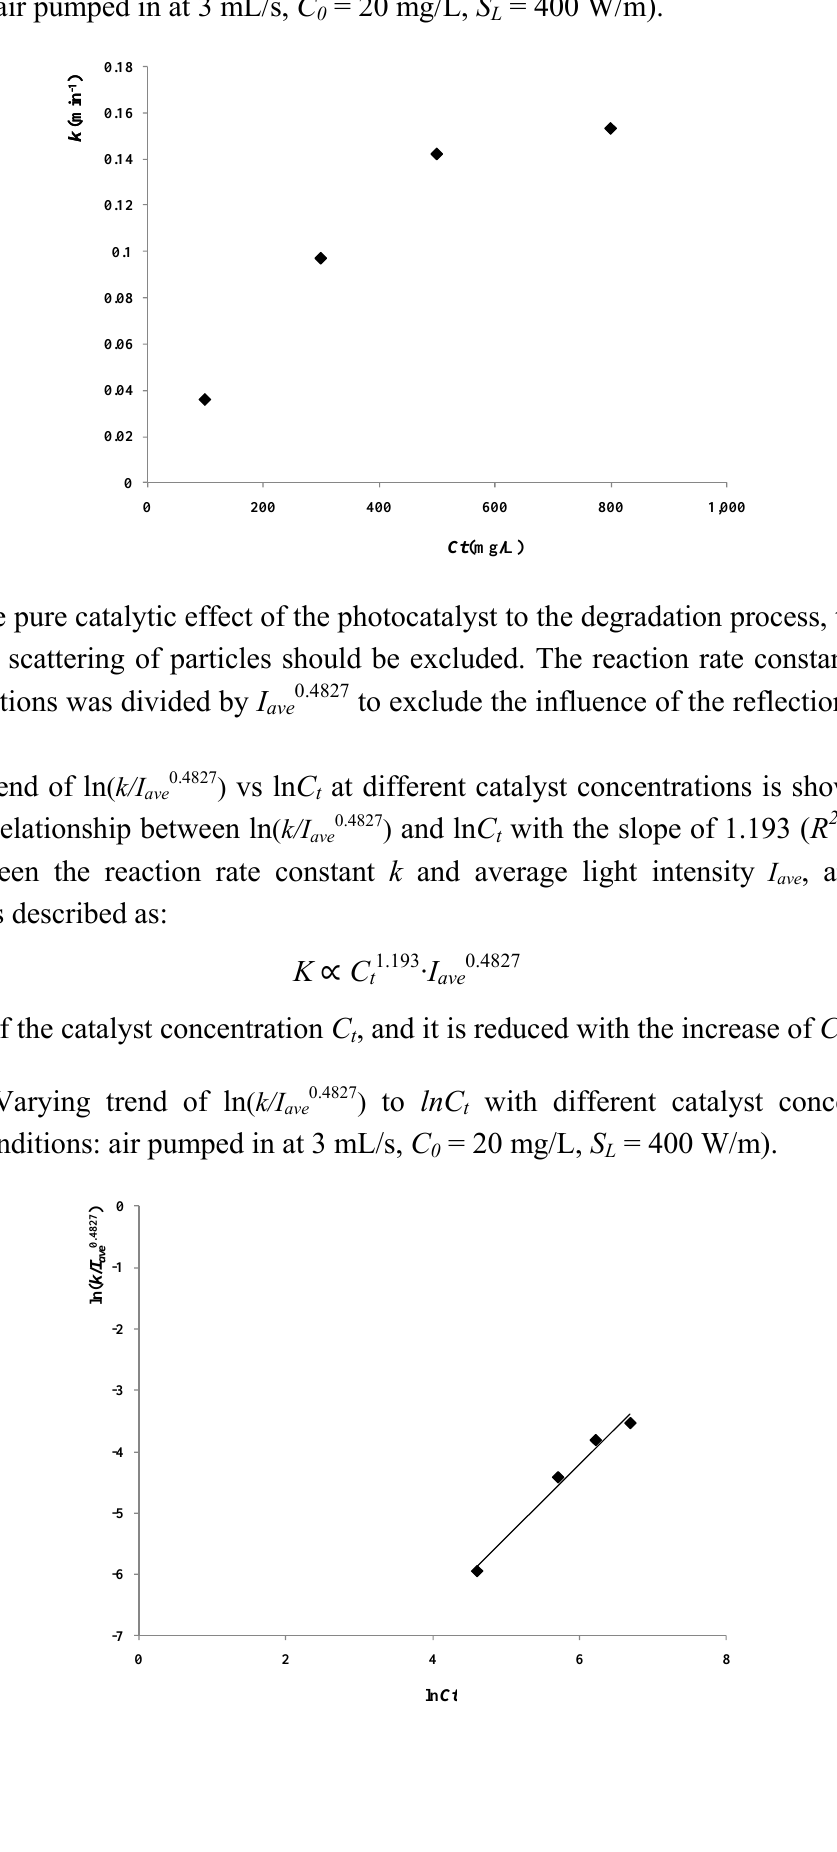
Figure 6. Varying trends of k to C conditions: air pumped in at 3 mL/s, C